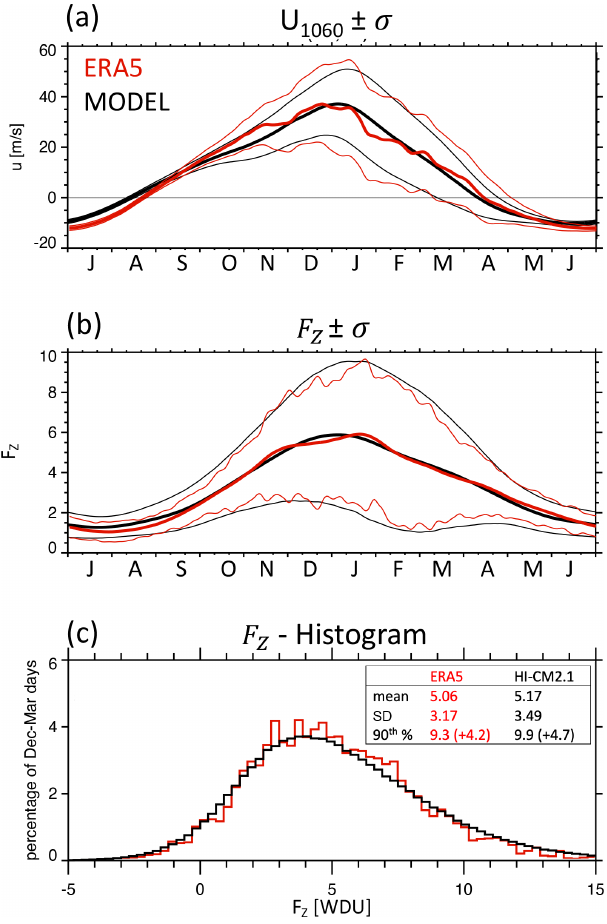
Figure 1. Model validation against ERA5 reanalysis (1979–2020) for (a) the (thick) climatological seasonal cycle of the zonal mean wind at 10hPa and 60 ◦ N ( u 1060 ; ms − 1 ) and (thin) its ± 1 standard deviation, (b) the (thick) climatological seasonal cycle of the strato- spheric wave driving ( F Z ; − 10 5 kgms − 4 , or WDU) and (thin) its ± 1 standard deviation, and (c) the daily distribution of F Z during northern winter (DJFM). Inset in (c) shows the mean, the standard deviation, and the 90th percentile of the two